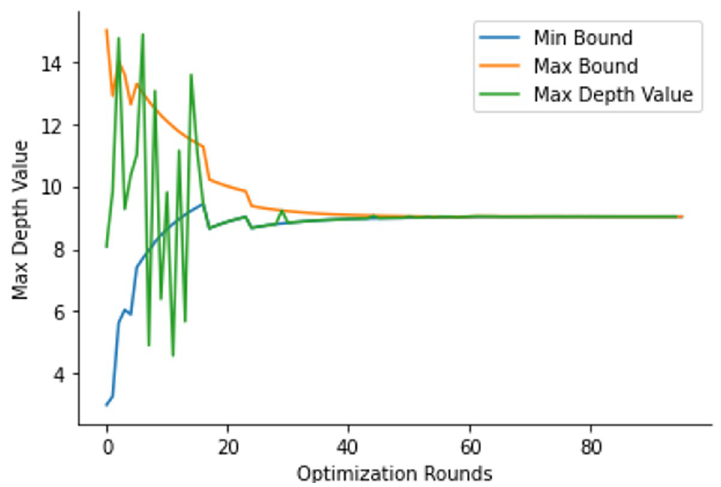
Fig 2. Sequential domain reduction transformer on the “max depth”